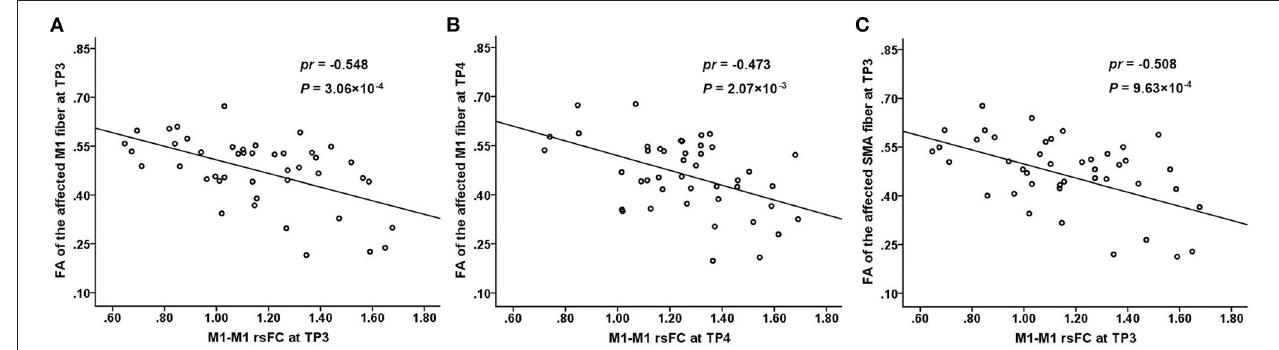
FIGURE 3 | Correlations between the connectivity measures. There is a significantly negative correlation between the FA values of the affected M1 fiber and M1–M1 rsFC at TP3 (3 months post-stroke) (A) and TP4 (>6 months post-stroke) (B) after subcortical stroke. There is a significantly negative correlation between the FA